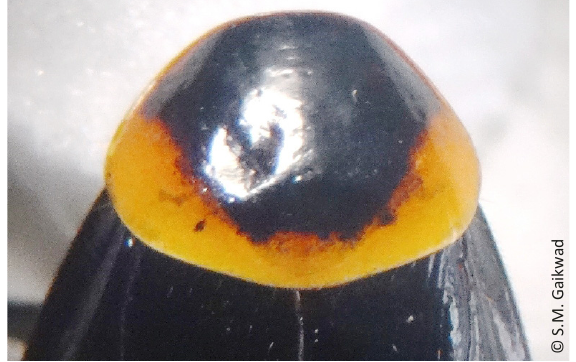
Image 2. Hemithyrsocera palliata (Fabricius, 1798) - ventral view